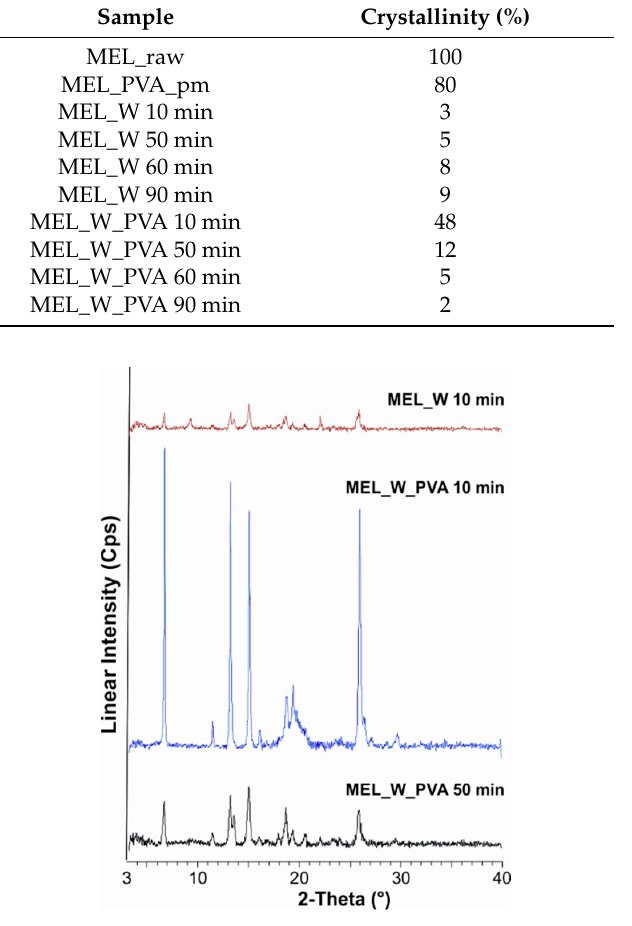
Figure 2. XRPD examination of MEL_W 10 min, MEL_W_PVA 10 min and MEL_W_PVA 50 min.